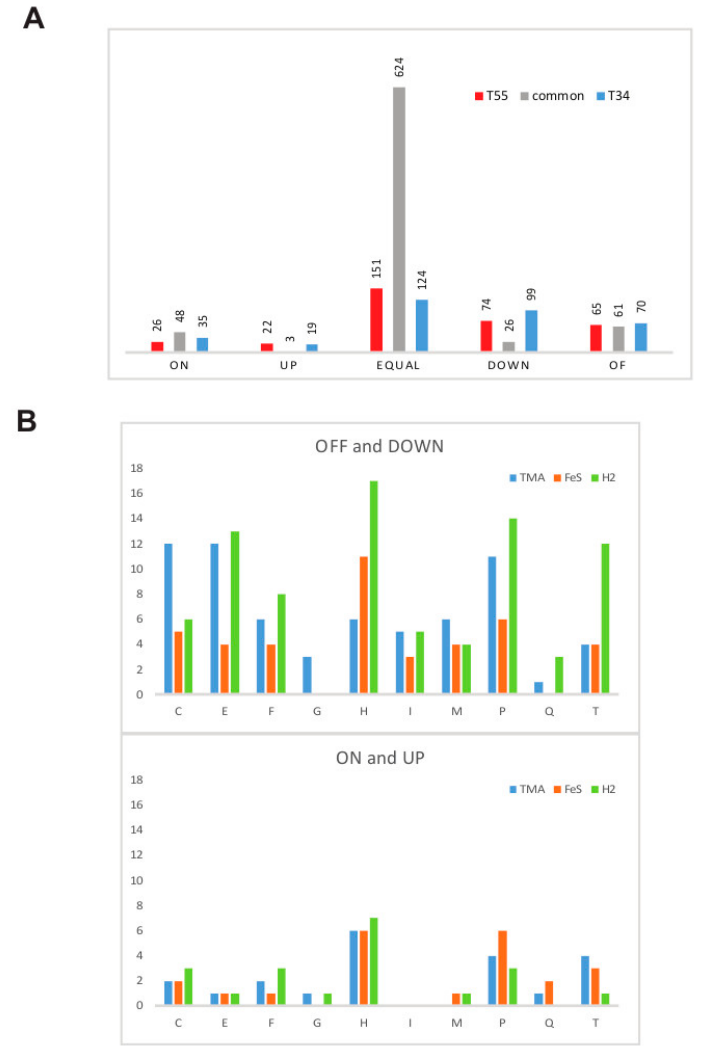
Figure 4. Protein abundance changes in response to non-optimal conditions. ( A ) Comparison of response to supra- and suboptimal temperature conditions. The bars show the number of proteins. ( B ) Comparison of the response to different growth factors for different functional categories. The bars show the number of proteins. Upper panel show upregulated proteins and bottom panel show downregulated proteins. Functional categories are by one letter code as follows: E—Amino acid